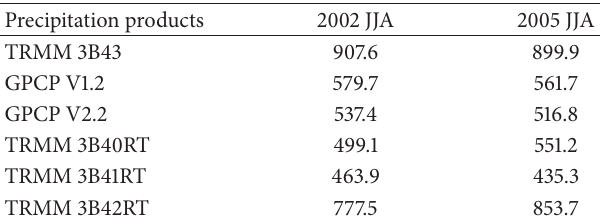
Table 1: The precipitation amount (mmmonth − 1 ) over 92 ∘ -93 ∘ E, 19 ∘ –21 ∘ N in JJA of 2002 and 2005. Precipitation